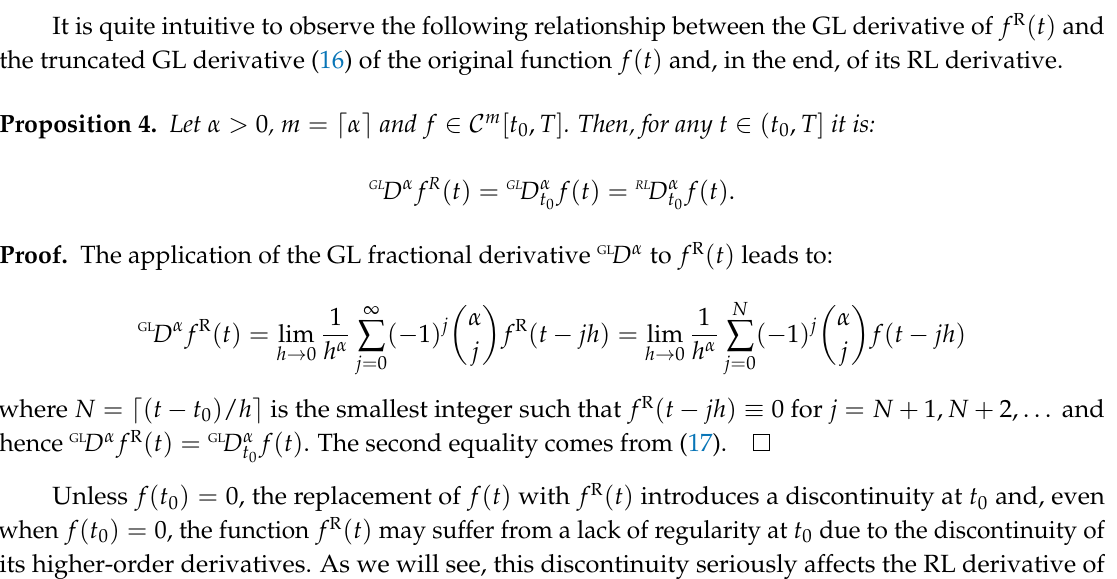
Figure 1. Replacement of f ( t ) (dotted and solid lines) by f R ( t ) (solid line) for a given point t 0